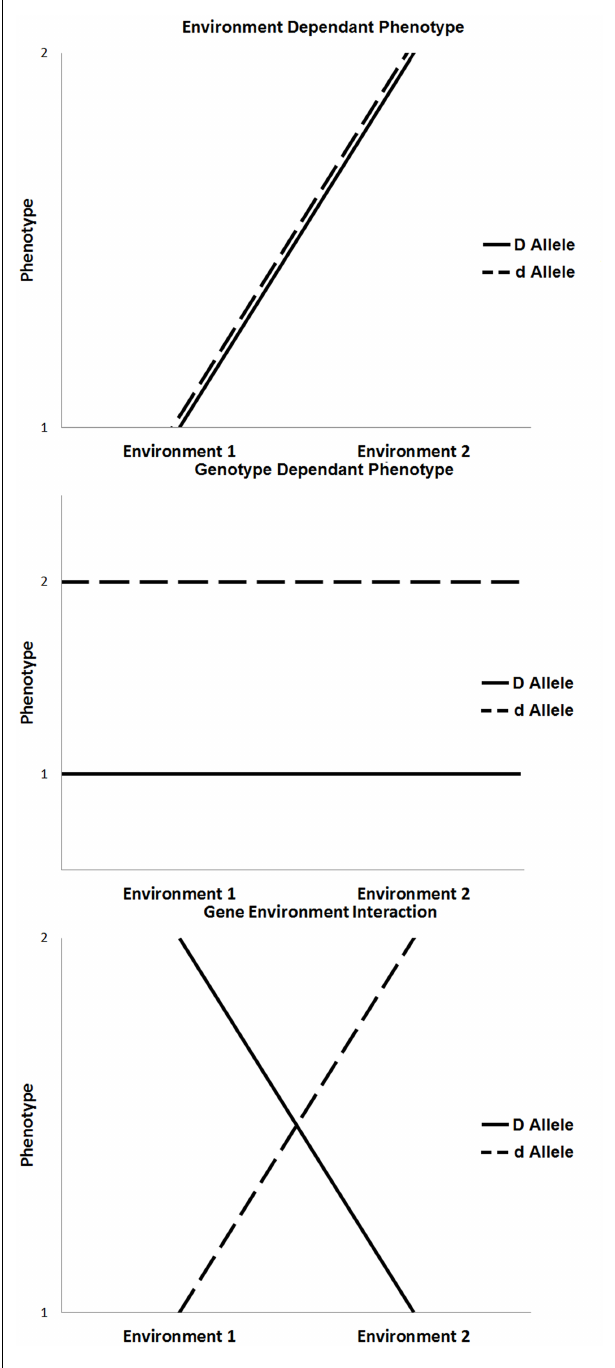
FIGURE 1 |Three scenarios that influence phenotypic expression, such as environment only influence, genotype only influence, and the influence of gene × environment interaction